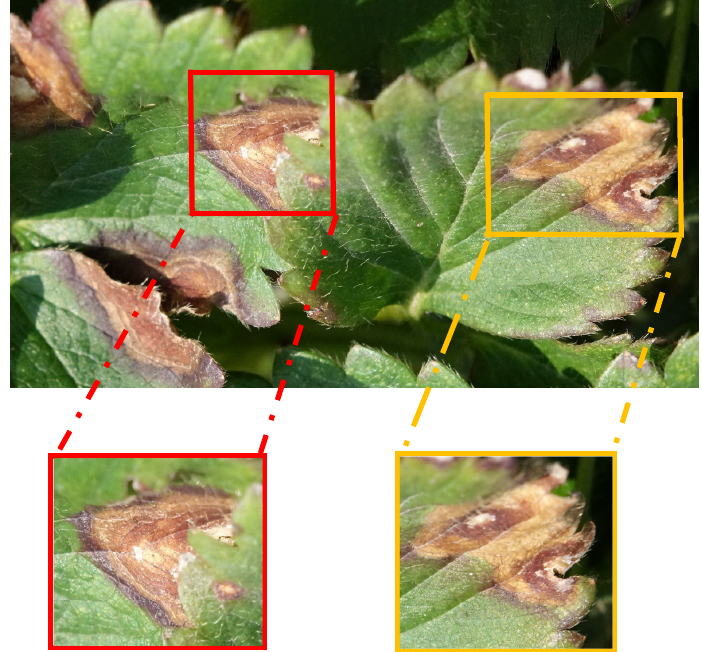
Figure 5. Schematic diagram of original image feature